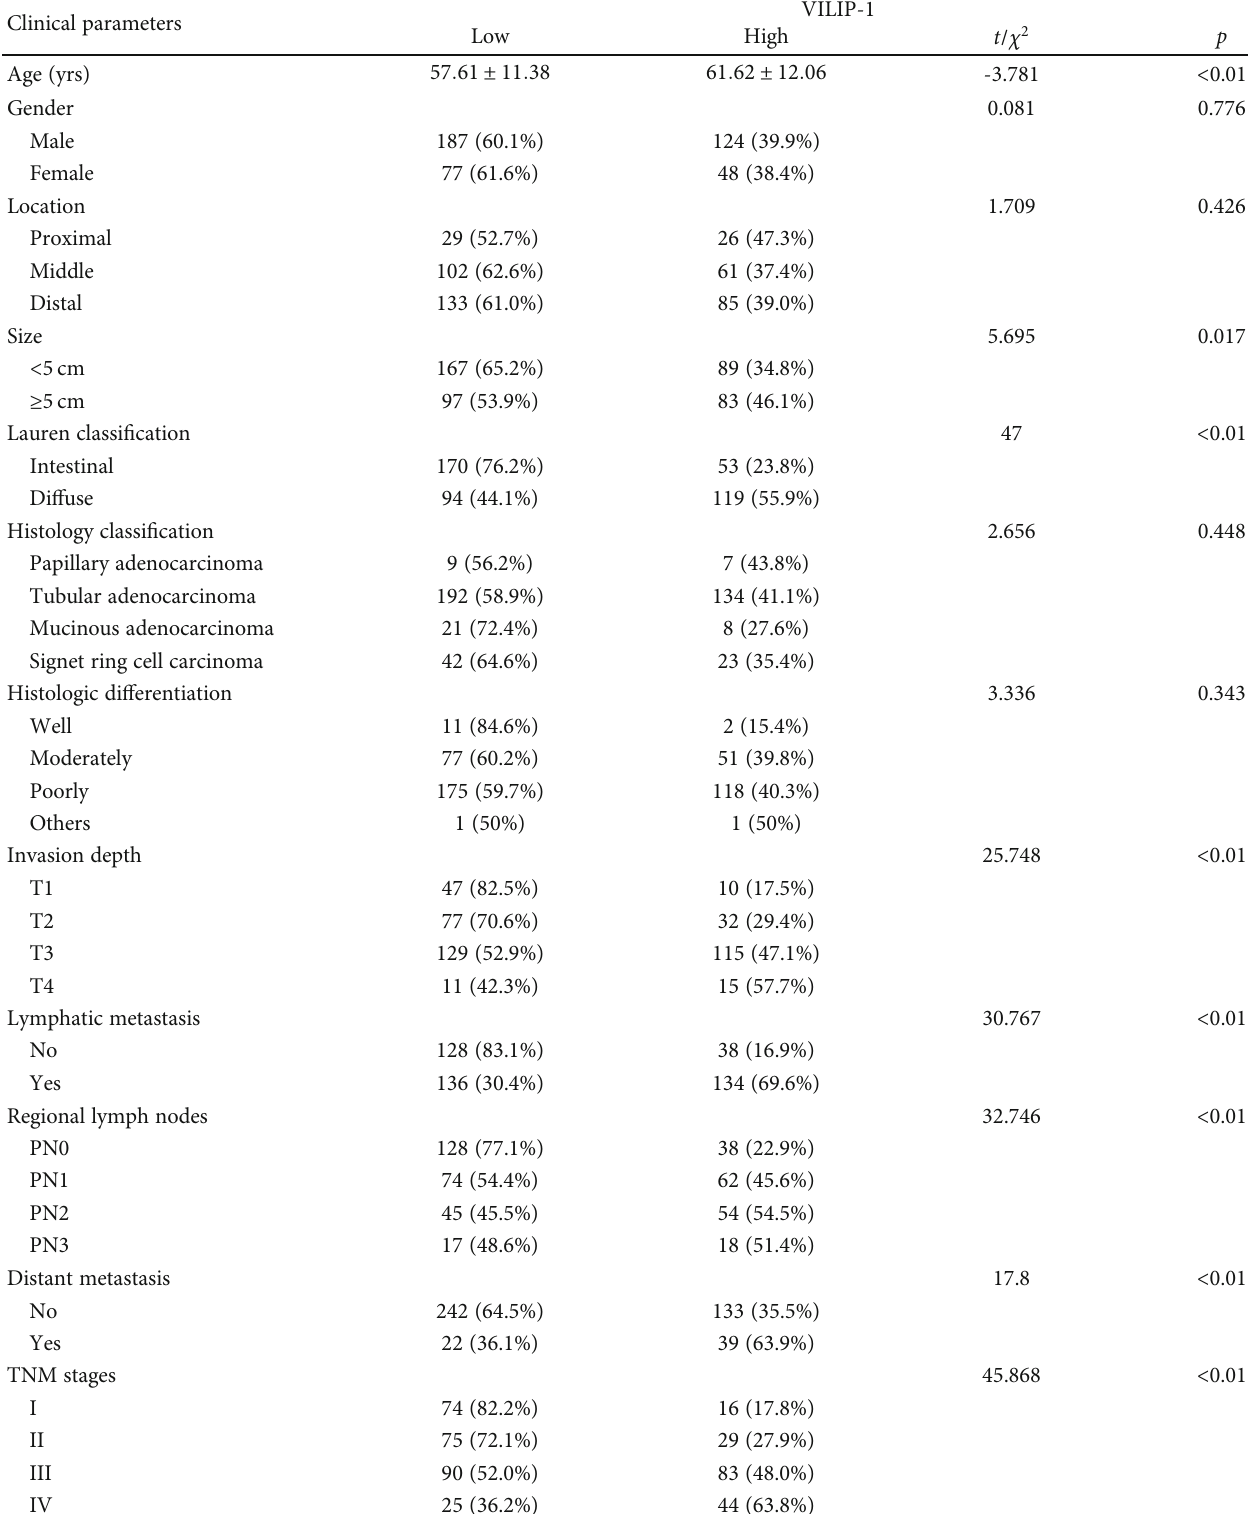
Table 1: Relationship of VILIP-1 expression with pathological parameters of